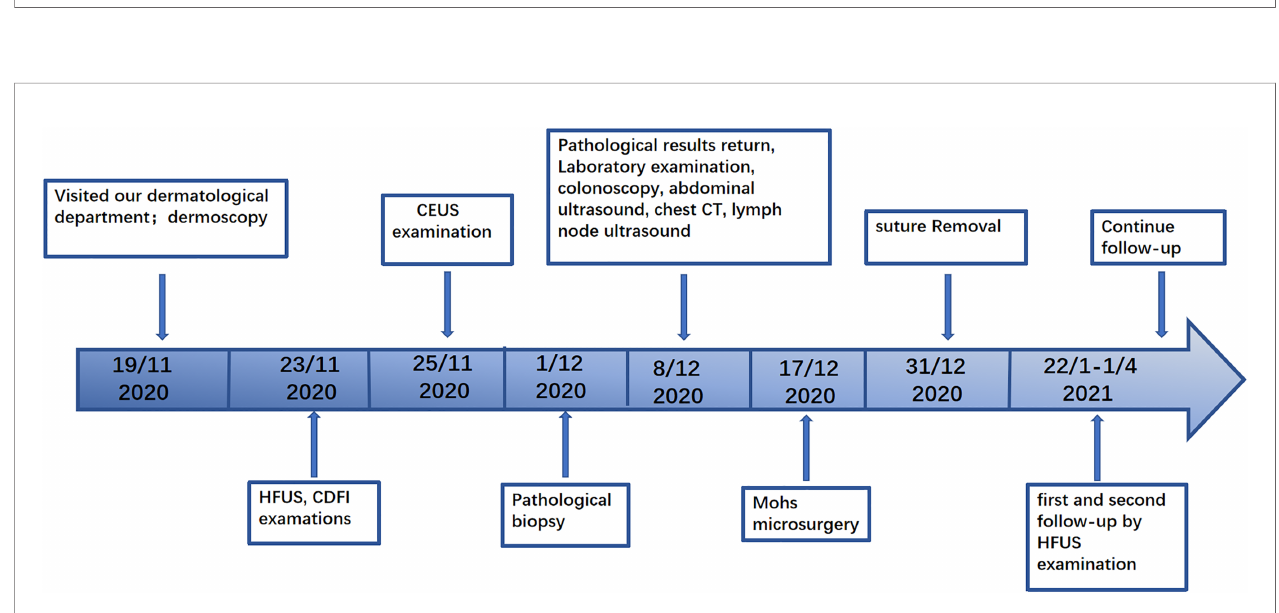
FIGURE 6 | Detailed operation steps of LBD tension-reducing suture follow the panels A – H .